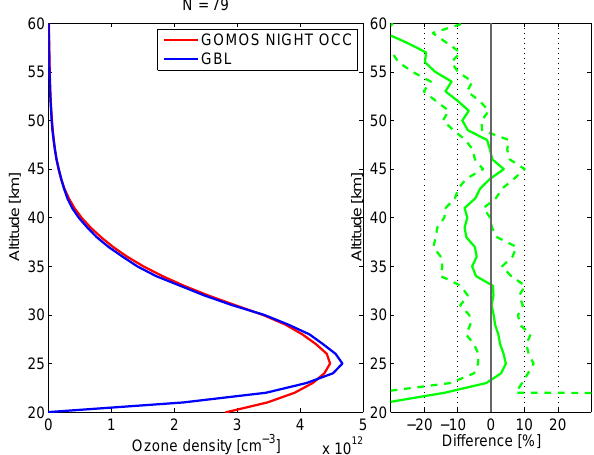
Fig. 8. Median relative difference of the 14 OSIRIS and stray light corrected GOMOS radiance ratios at 30 km (blue) and 55 km (red). Radiances were normalized with the 47 km spectrum. Fig. 9. Retrieved ozone profiles from the 14 GOMOS and OSIRIS radiances of Figs. 6 and 8. Left panel: medians of the OSIRIS profiles (blue), GOMOS profiles retrieved with the UV band (red dashed profile) and without using the UV band below 40km (red solid profile). Right panel: medians of individual relative differ- ences compared to the OSIRIS profiles and the 25th and 75th per- centiles. The red lines show the difference (and deviation) when using the UV band and the green lines show the difference when the UV band is not used.